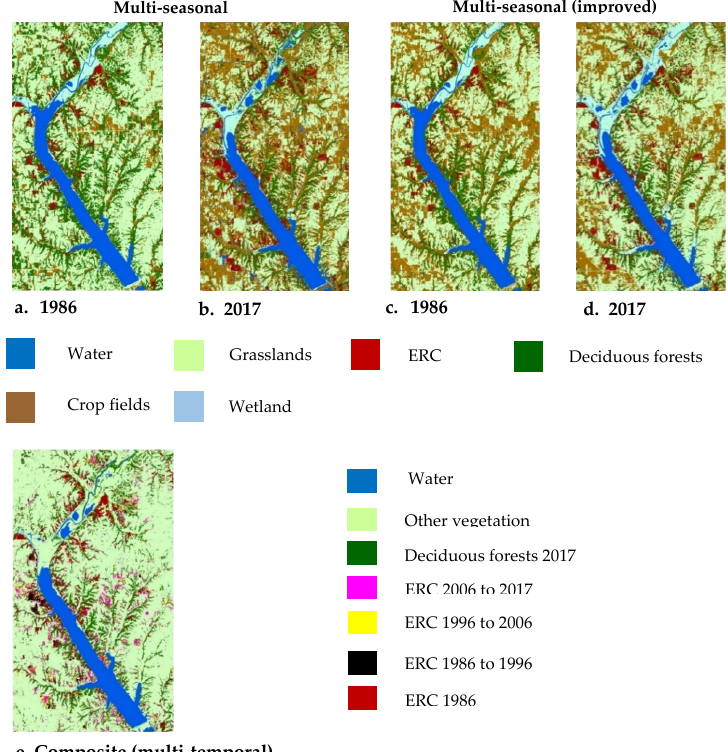
Figure 3. Image preparation method comparisons. Multi-seasonal SVM classification ( a ) 1986 and ( b ) 2017. Multi-seasonal (improved) classification ( c ) 1986 and ( d ) 2017. ( e ) Composite (multi-temporal) image classification with SVM.